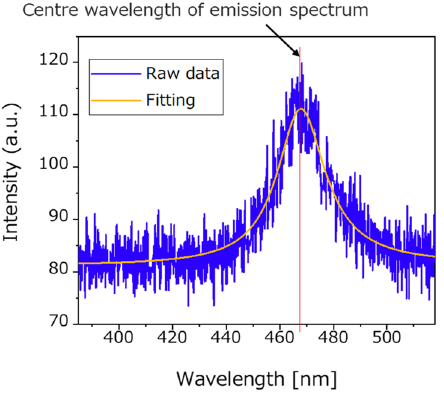
Figure 4. Typical raw spectrum data and fitting curve fitted by